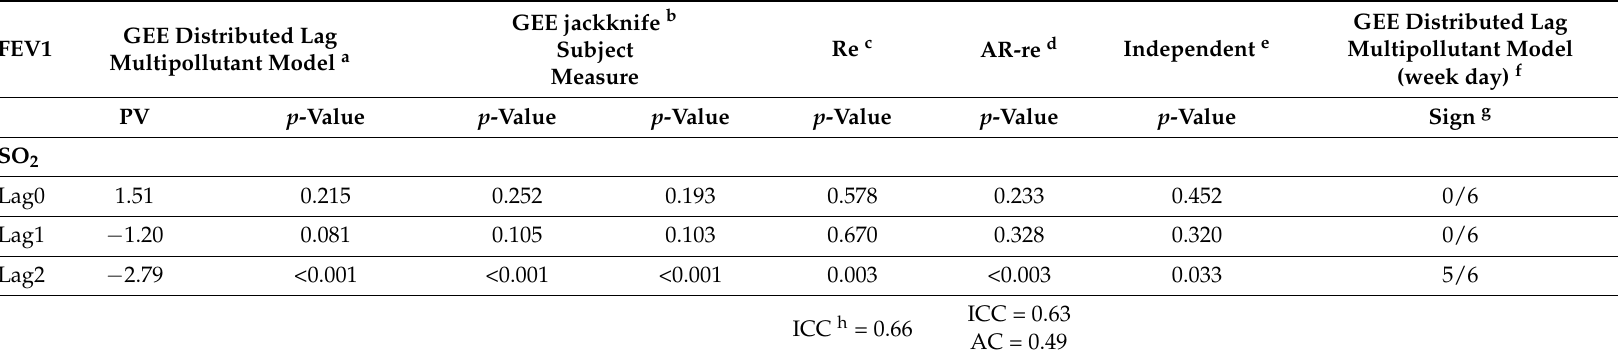
GEE Distributed Lag Multipollutant Model (week day) f